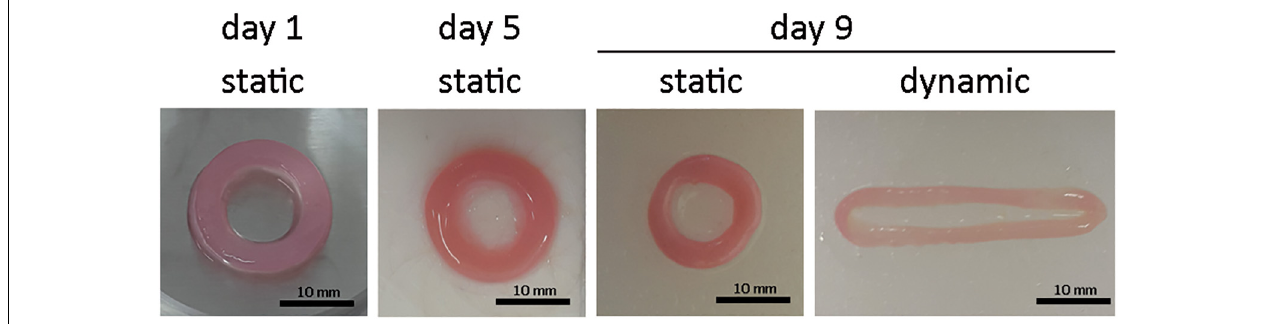
FIGURE 2 | ECT shape remodeling. Representative macroscopic pictures showing the top view of an explanatory ECT at the beginning (day 1) and at day 5 of the culture, and following either static or dynamic culture (day 9). Scale bar = 10 mm.